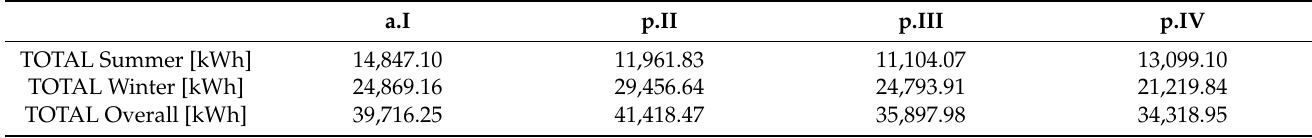
Table 5. Summer, winter and overall annual energy demand.